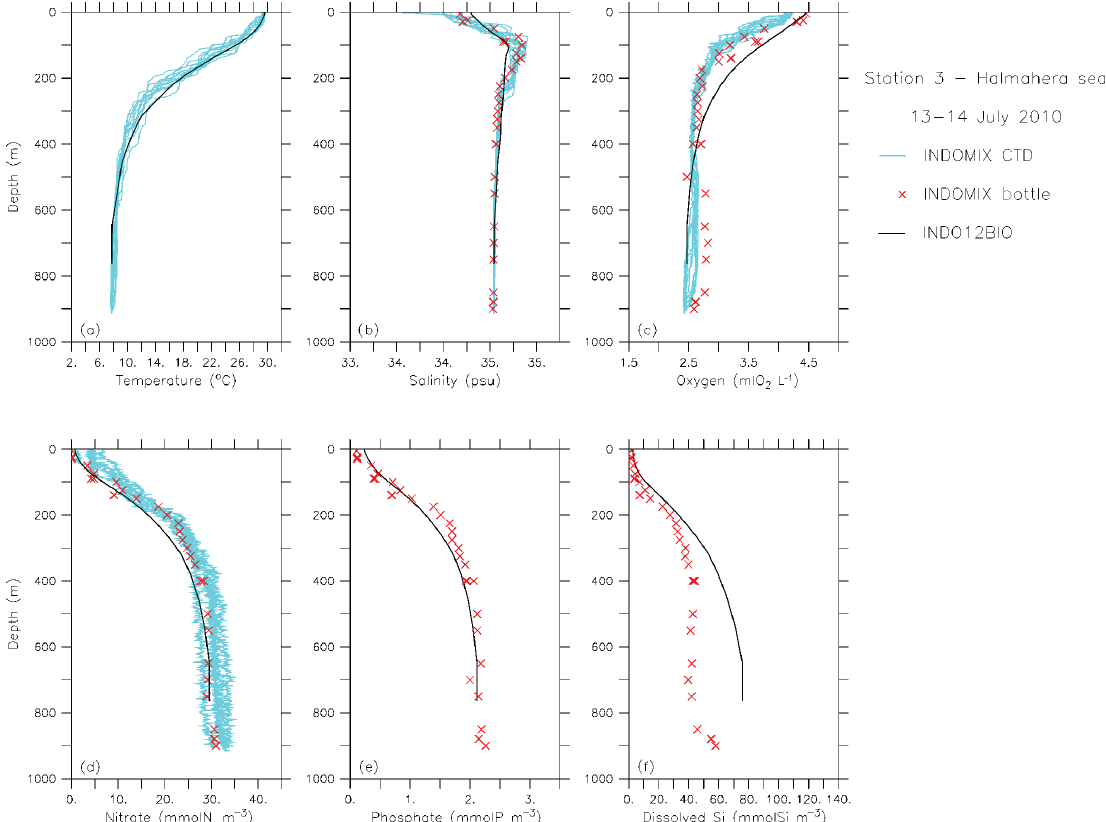
Figure 12. Vertical profiles of temperature ( ◦ C; a ), salinity (psu; b ), oxygen (mLO 2 L − 1 ; c ), nitrate (mmolNm − 3 ; d ), phosphate (mmolPm − 3 ; e ) and dissolved silica (mmolSim − 3 ; f ) concentrations at INDOMIX cruise station 3 (Halmahera Sea; 13–14 July 2010). CTD (light blue lines) and bottle (red crosses) measurements represent the conditions during cruise, 2-day model averages are shown by the black